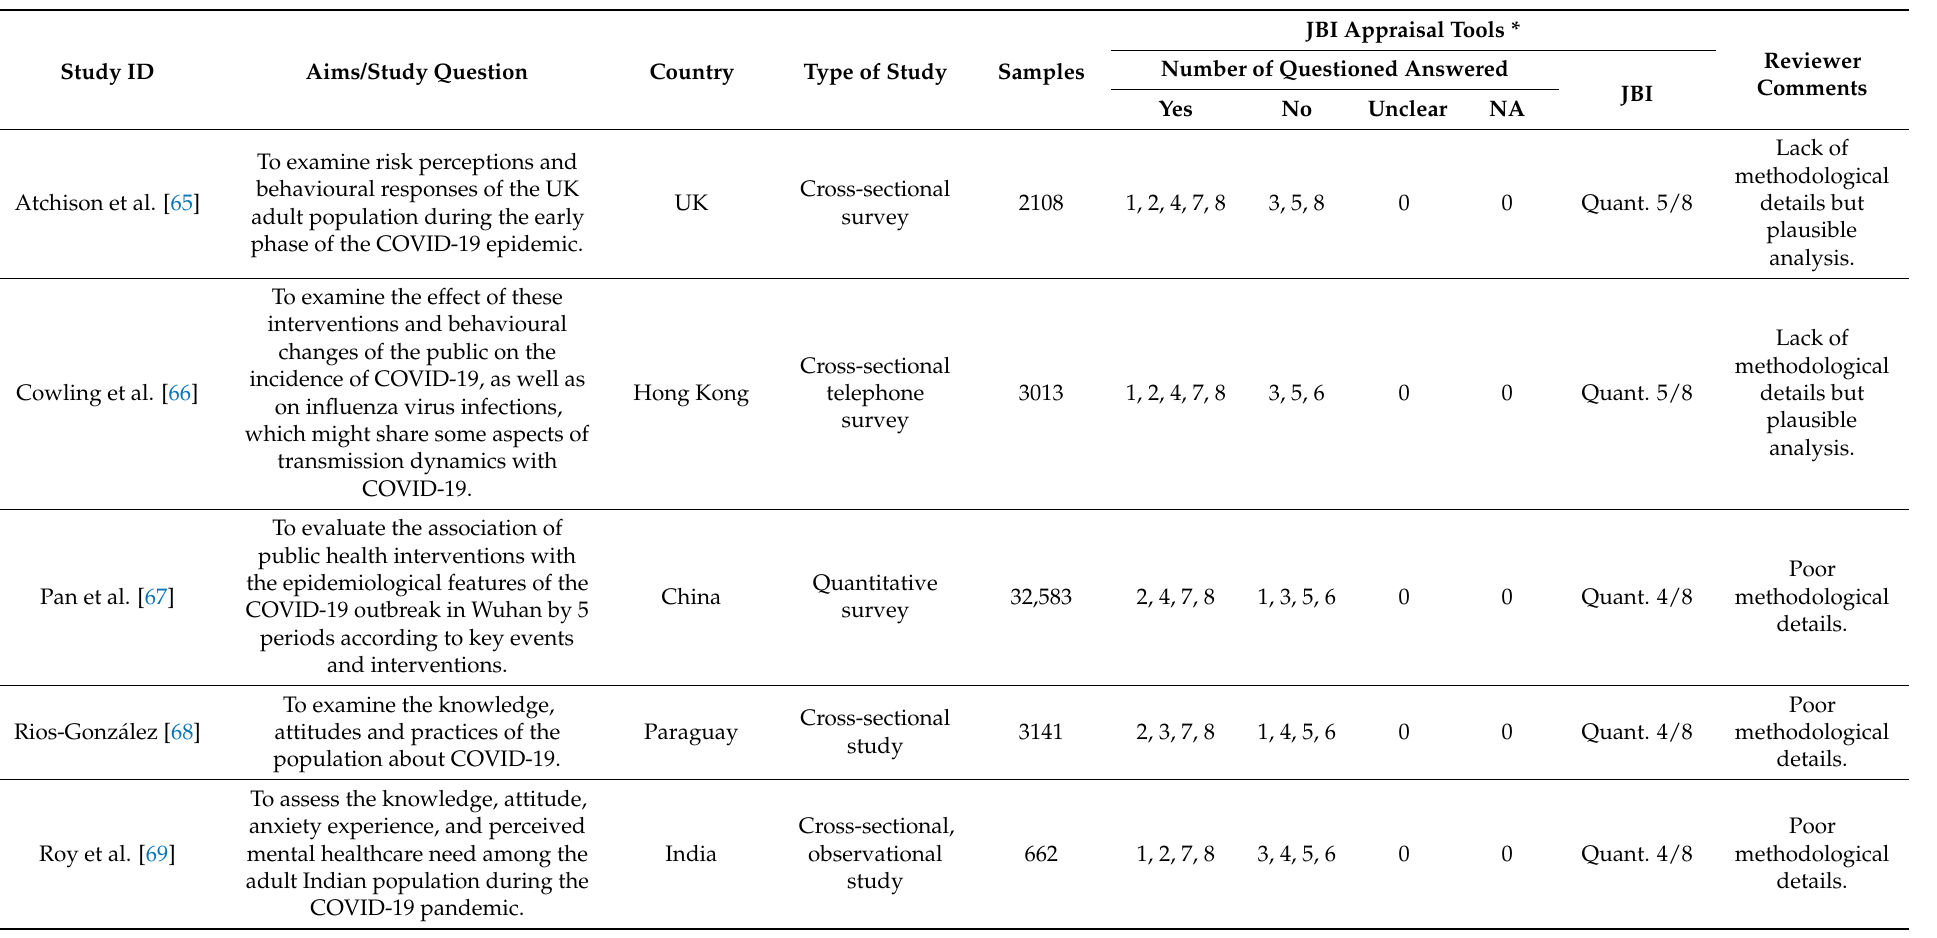
Table 2. Summary of selected